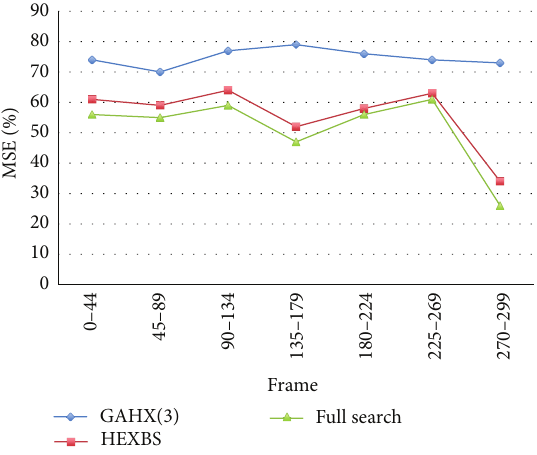
Figure25:AveragepercentrateperframeofPSNRworsethan30 dB compared with various schemes for Mobile video